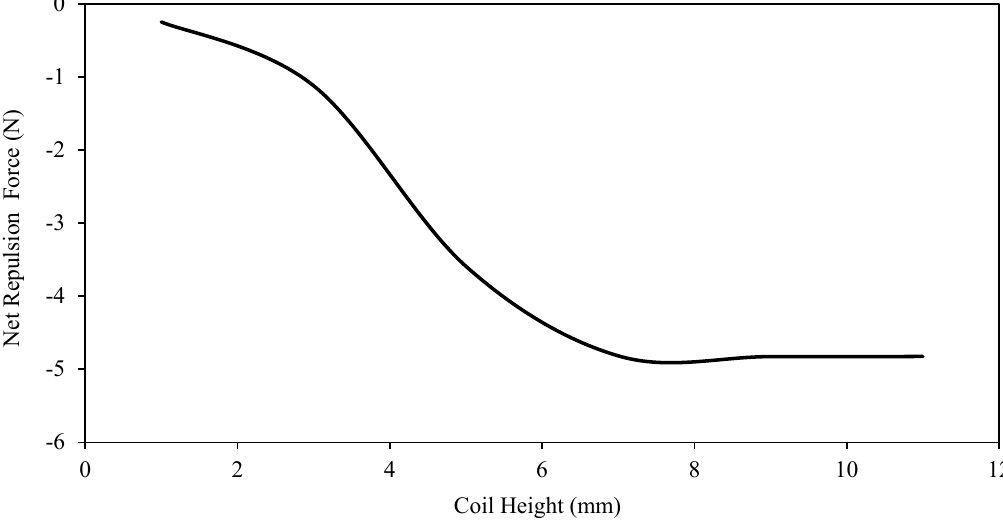
Figure 10. Net repulsion force on the permanent magnet at its zero-stroke position versus coil height.